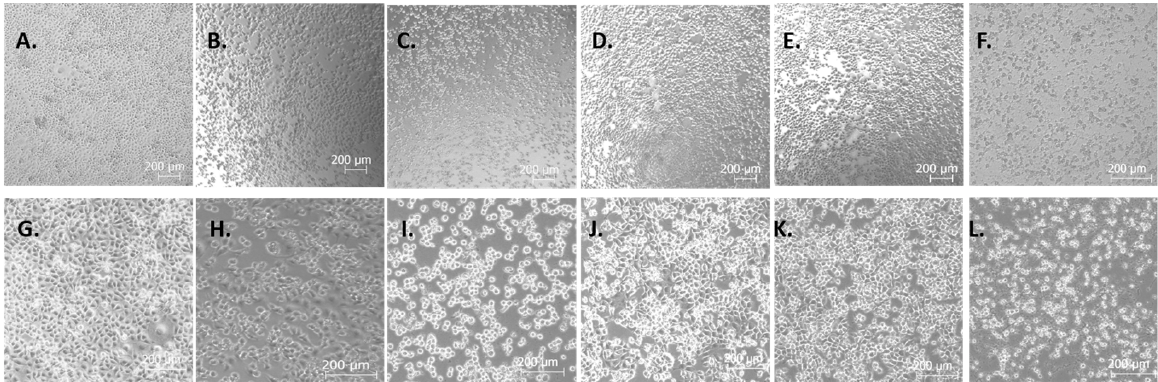
Figure 3. Morphological changes of MDA-MB-231 cells when treated with compounds or vehicle. At 5×: ( A ) DMSO, ( B ) 8 (5 μ M), ( C ) 8 (10 μ M), ( D ) 2 (5 μ M), ( E ) 2 (10 μ M), ( F ) STS (2 μ M). At 10×: